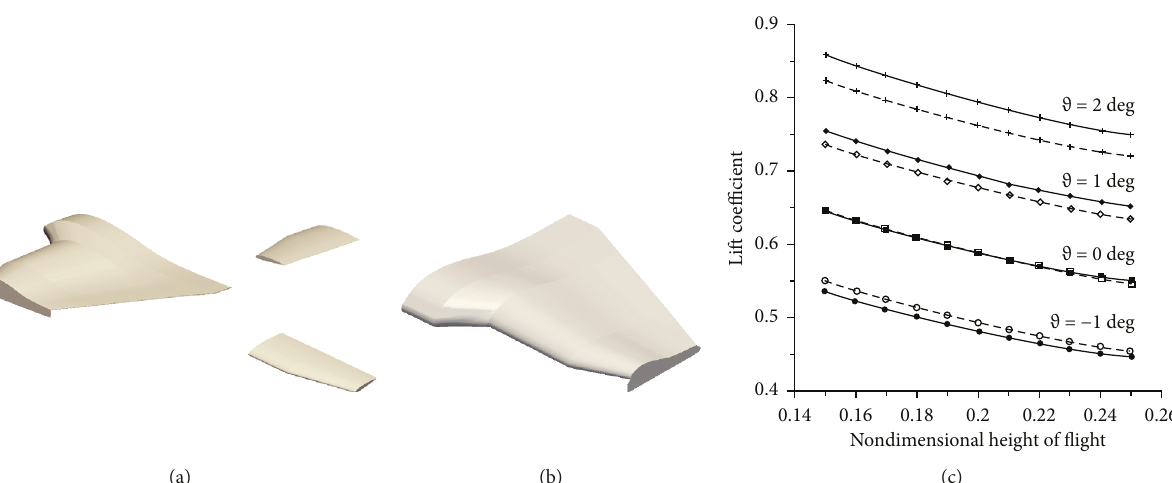
Figure 5: Half of the schematic con fi guration of the SeaFalcon WIG (a, b) and lift coe ffi cient (c) versus the nondimensional height.